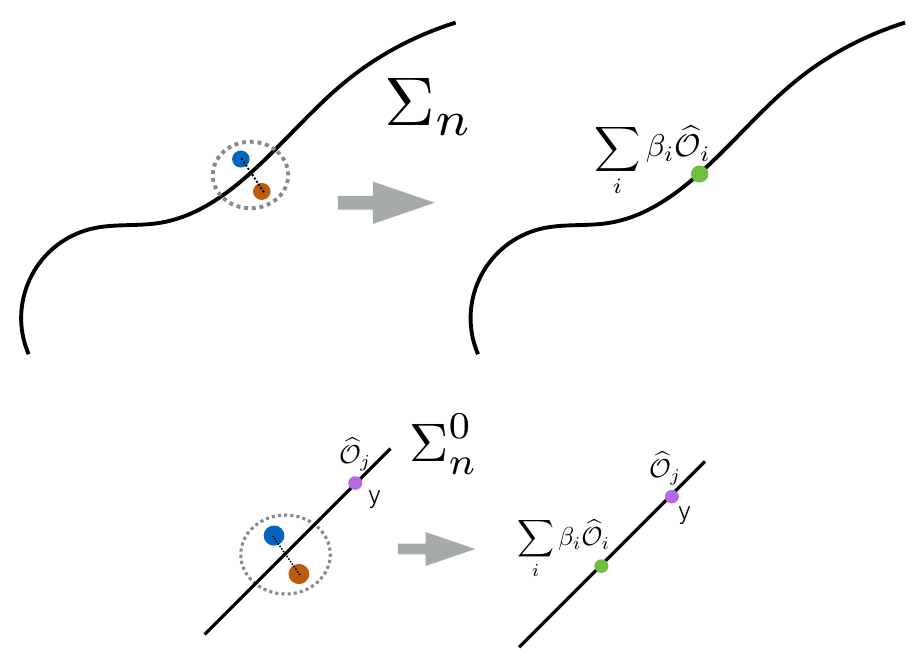
Figure 3 . ( Upper ) The defect OPE argument is based on bringing the two to the defect and replacing these with a sum over defect operators. The dashed line between the operators represents the non-local string we need in order to study these operators in the orbifold theory. The dashed circle represents the radial quantization sphere in the defect theory on which we decompose the state in a basis of local operator insertions at the origin of this sphere. ( Lower ) The OPE coe(cid:14)cients (cid:12) i can be computed by making the same replacement, but now on a defect which allows us to do the computation. That is on a (cid:13)at defect in vacuum. The other operator is inserted elsewhere on the defect so we can extract the various (cid:12) i